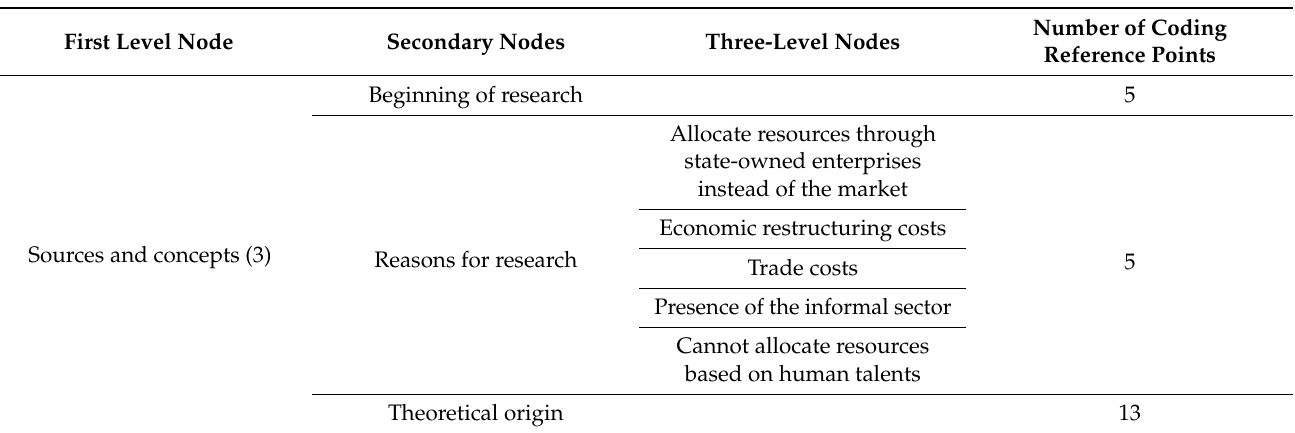
Table 2. Number of nodes at all levels and coding reference points included in the sources and concepts node.